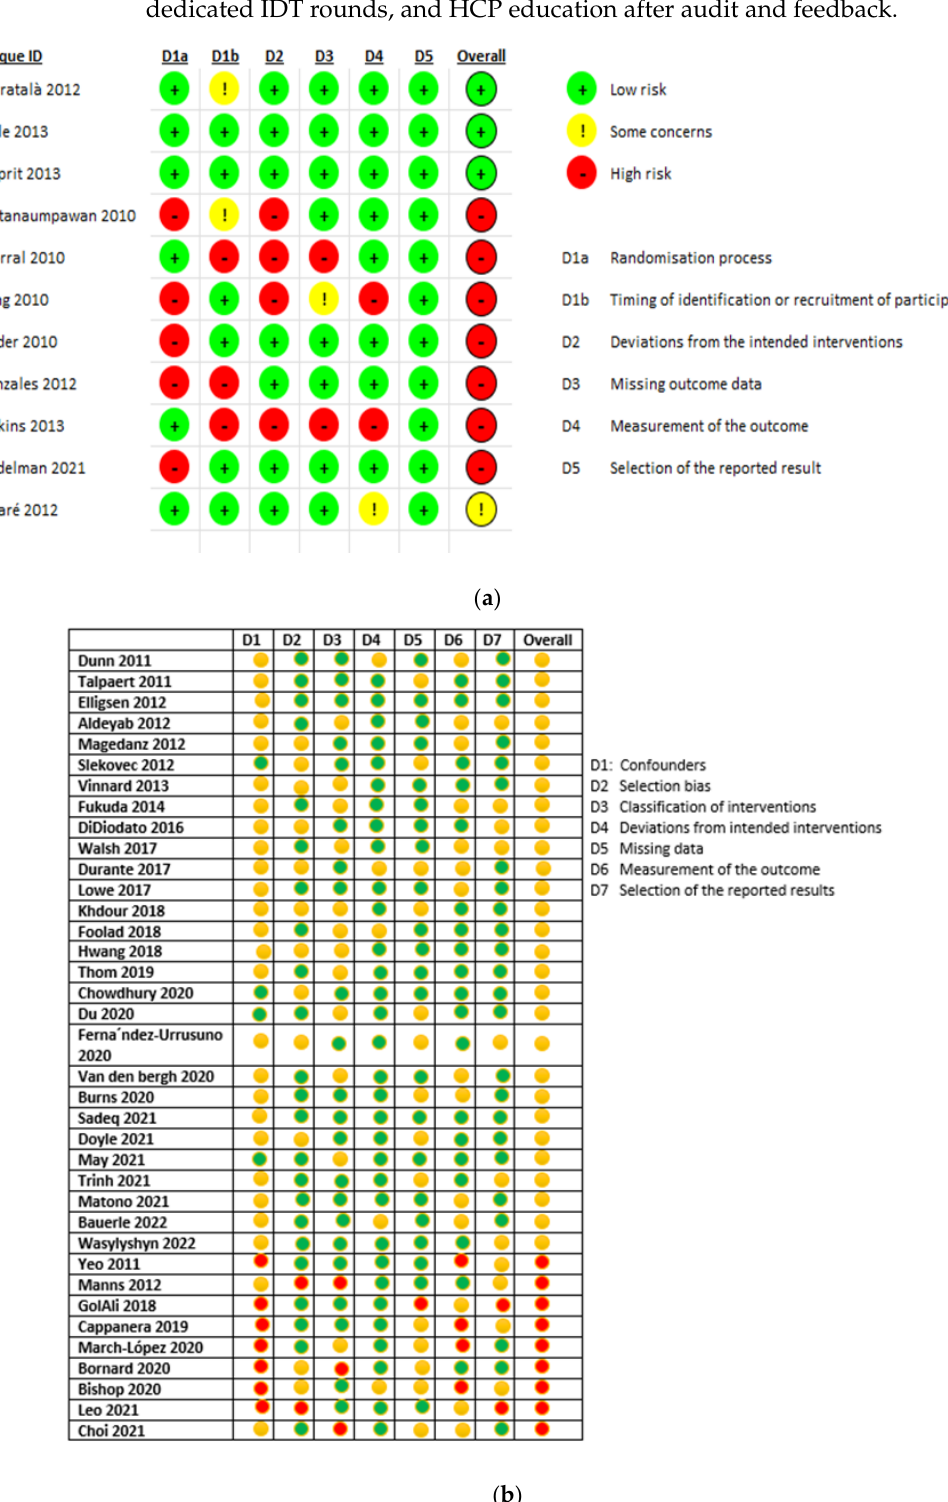
Figure 2. ( a ) RCTs risk of bias assessment using ROB-2 tool; ( b ) ROBIN-1 risk of bias assessment for non-randomized trials.